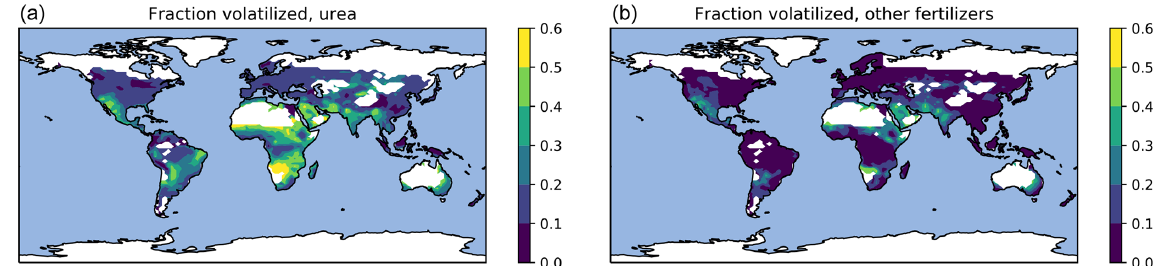
Figure 8. Fraction of fertilizer N lost due to volatilization averaged for 2010–2015: urea (a) and other synthetic fertilizers (b)